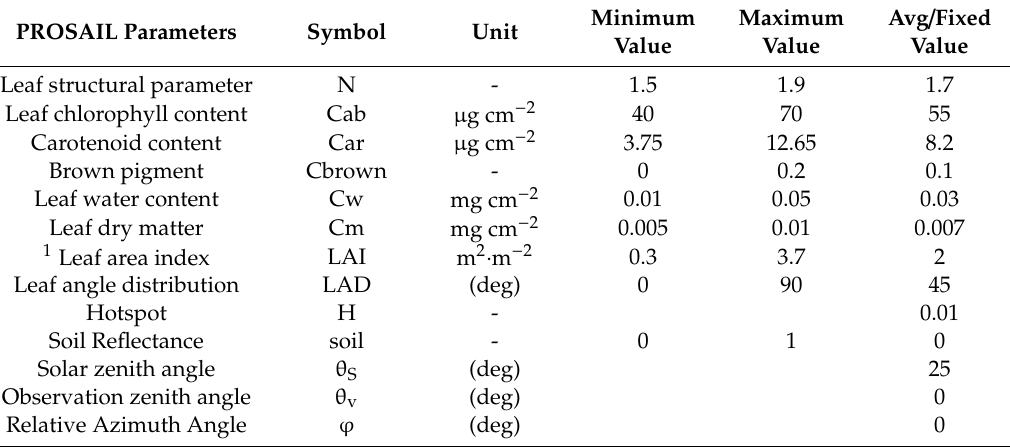
Table 3. Input parameters used in the global sensitivity analysis (GSA). LAI was estimated from the canopy fAPAR measurements at IT-MBo. The ranges of other input parameters (N, Cab, Car, Cw, Cm, Cbrown, soil and LAD) were selected based on existing literature